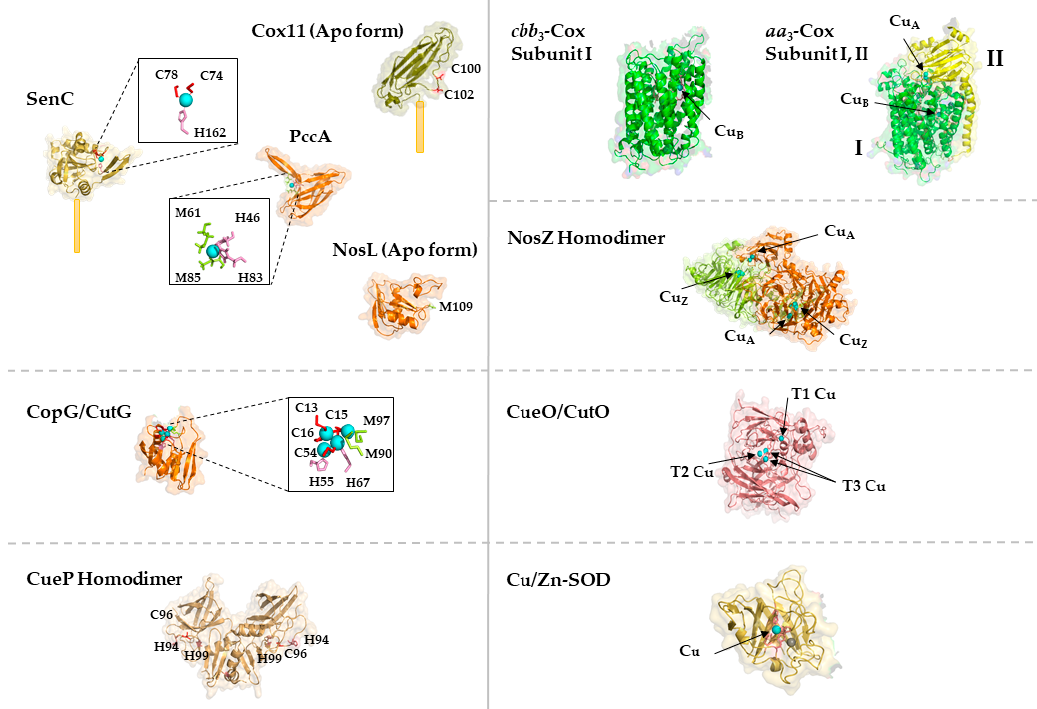
Figure 10. Periplasmic Cu chaperones and their target cuproproteins. The structures of Cu-chaperones are shown in the left and their corresponding target proteins in the right panels. The respective Cu binding sites are indicated, and Cu ions are shown in cyan. The ScoI-homologue SenC and Cox11 contain a single transmembrane domain of unknown structure indicated by a yellow box. NosZ, which was crystallized as homodimer, contains two Cu binding sites; for the Cu A center, PccA/PCu A C and SenC/Sco1 are required, while NosL is involved in the formation of the Cu Z center. Structures were retrieved from the protein database (PDB) with the following IDs: 4WBR (ScoI/SenC), 2K70 (PCu A C/PccA), 1SP0 (Cox11), 2HQ3 (NosL), 6WIS (CopG), 4GQZ (CueP), 5DJQ ( cbb 3 -Cox), 3FYE ( aa 3 -Cox), 6RZK (NosZ), 3OD3 (CueO), 1EQW (Cu/Zn SOD), and depicted using Pymol.